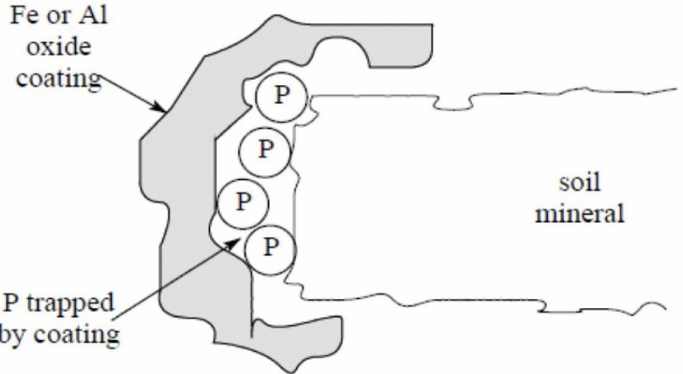
Figure 5. The occlusion of adsorbed phosphorus